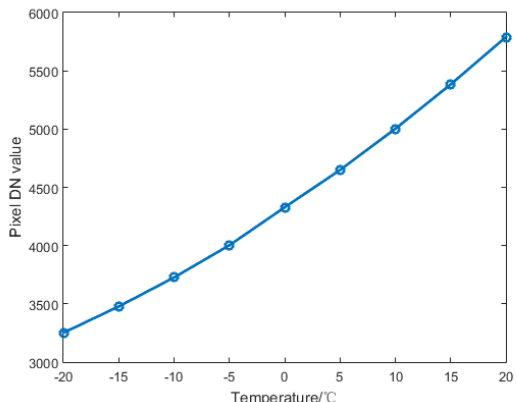
Figure5. RelationshipbetweenDigitalNumber(DN)valueoftheimageandtheblackbodytemperature. Figure 5. Relationship between Digital Number (DN) value of the image and the black body temperature.